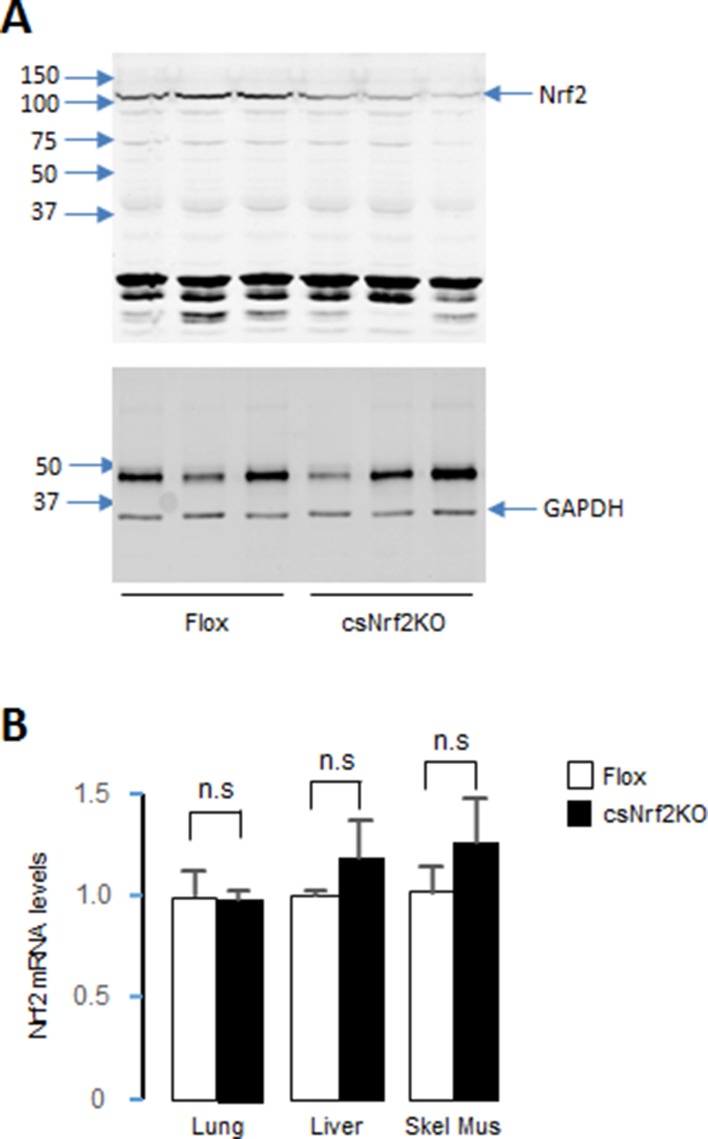
Identification of csNrf2KO mouse.(A) Full images of Western blot of Nrf2 using whole heart lysates from csNrf2KO mice and their littermate Flox controls. (B) Nrf2 mRNA levels by real-time PCR in different tissues including lung, liver and skeletal muscle (Skel Mus). n.s: no significance. n = 5/group.